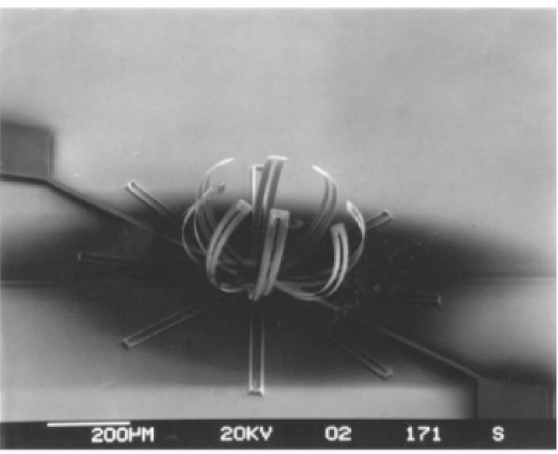
Figure 1. Thin film NiTi microwrapper. Reproduced with permission from Ref. [15].